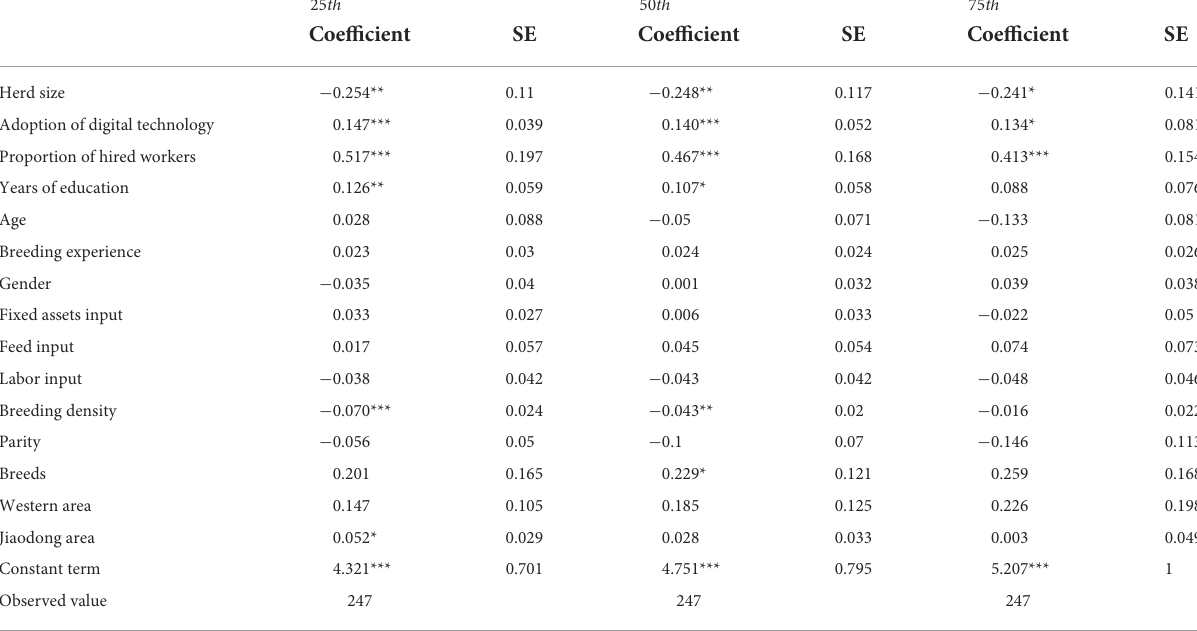
TABLE 7 Robustness test: influence of herd size on cow yield at different